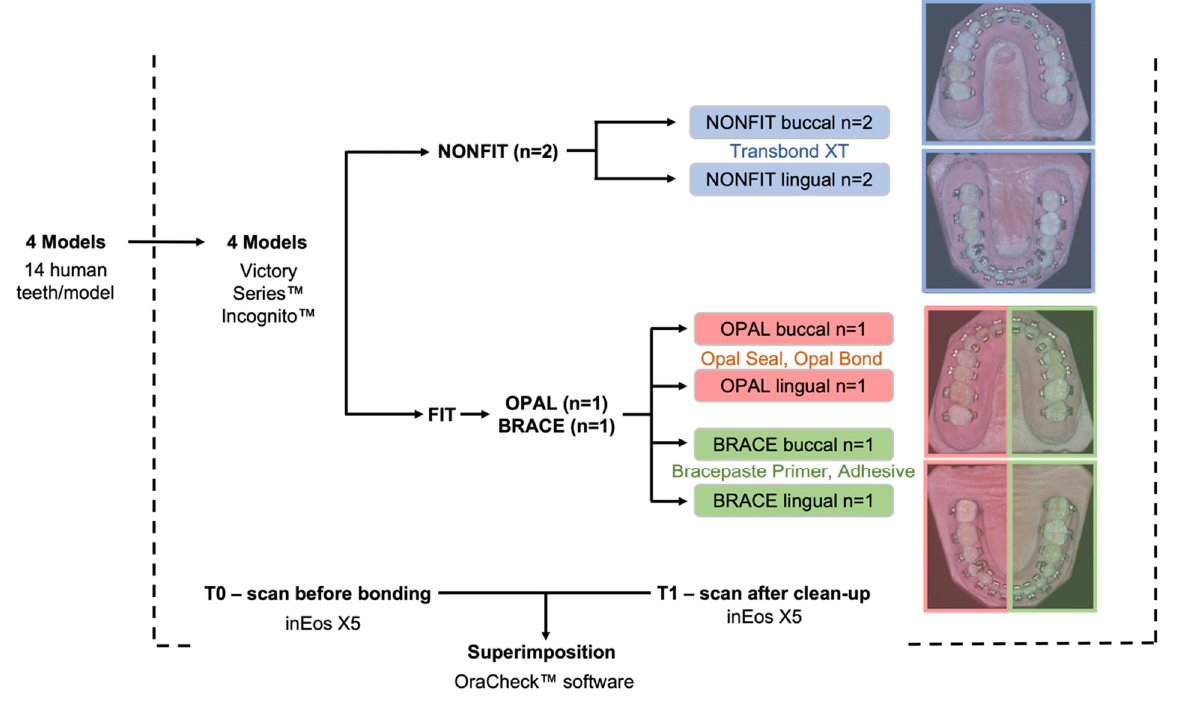
Figure 2. Study flow chart.